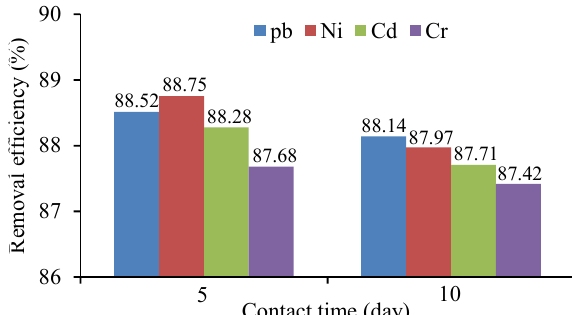
Fig. 5. Duckweed efficiency in combined heavy metal removal at concentration of 25 mg/l (duckweed weight: 1.2